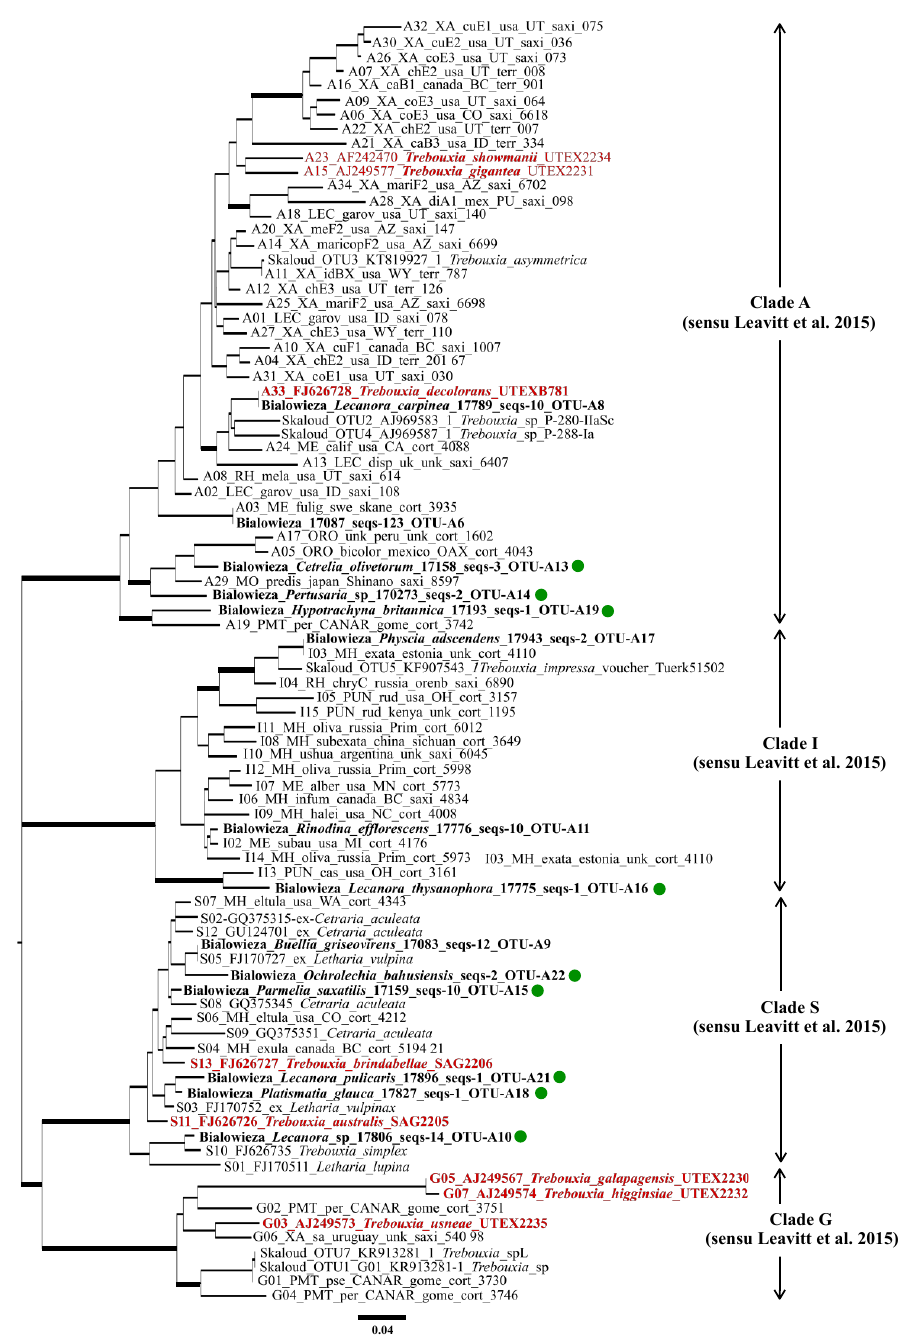
Figure 1. Internal transcribed spacer (ITS) gene tree constructed with the representative Trebouxia operational taxonomic units (OTUs) from this study, and 69 and seven representative OTUs from Leavitt et al. [19], and Škaloud et al. [48] respectively. Four major clades from Leavitt et al. [19] are indicated. ITS sequences from this study are in bold, and those from the SAG and UTEX culture collection are in red and bold. For the sake of reference to the already published dataset, the names of the representative OTUs from Leavitt et al. [19] and Škaloud et al. [48] are retained. The reference OTUs from this study are named according to the following scheme: Locality, DNA / sample ID, number of sequences of that OTU in the dataset, and lastly, Trebouxia OTU number. Novel OTUs are indicated with a green dot in front of the name of the representative OTU